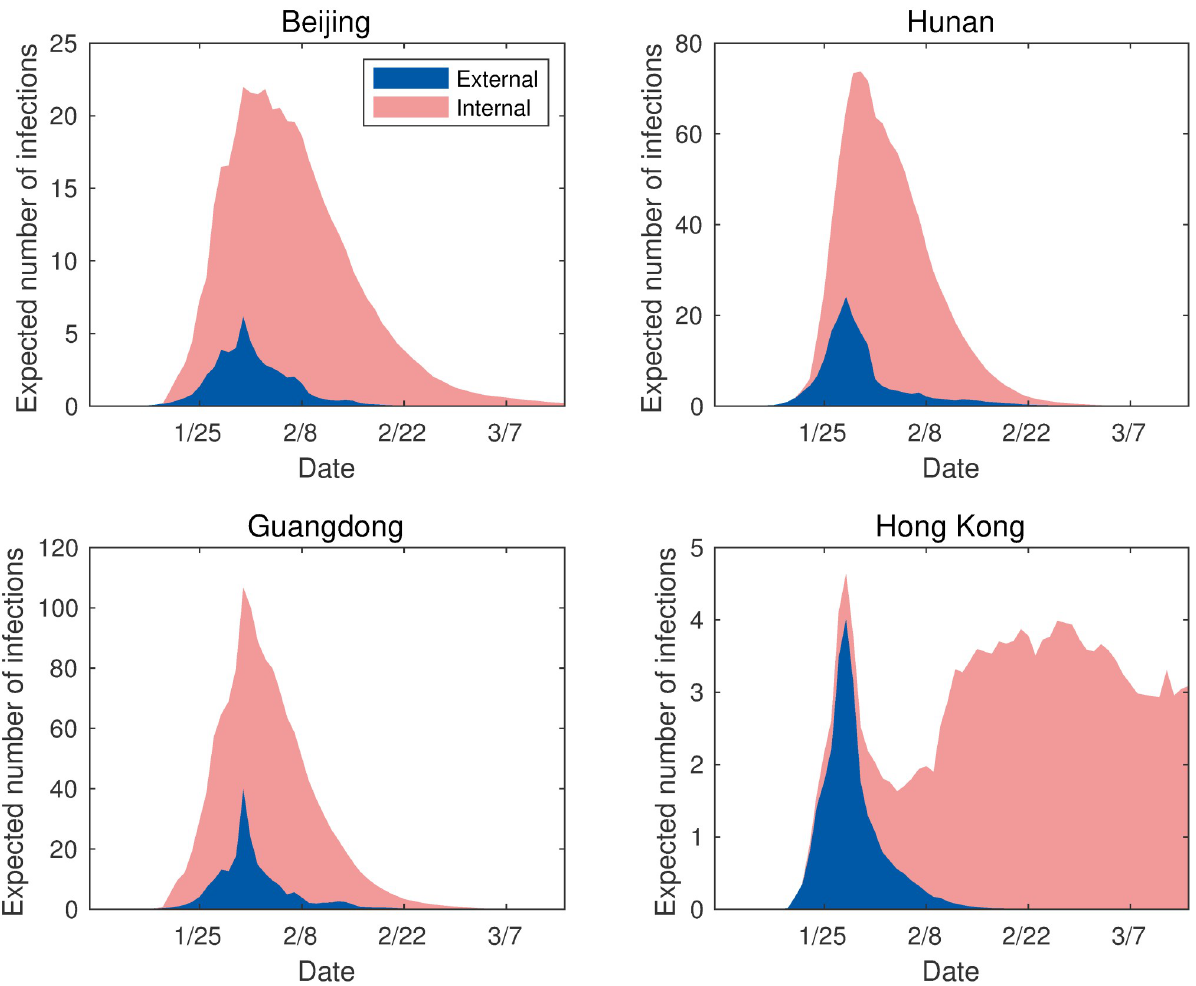
Fig 3. External vs internal transmission: The number of infected individuals. The figures show the expected number of infections due to the external infection (the blue area) versus the expected number of infections due to internal infection (the pink